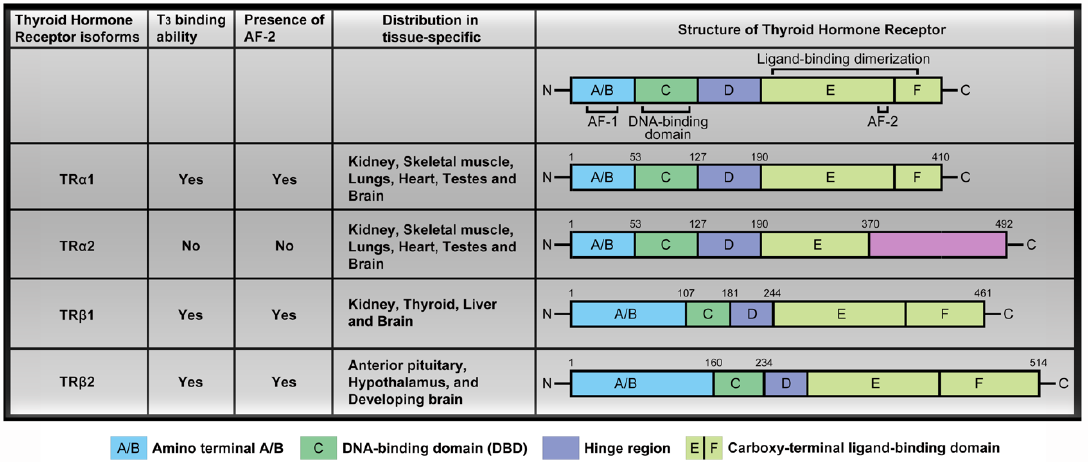
Figure 1. Thyroid hormone receptors (TR) isoforms and structure distribution. Thyroid hormone receptors (TR) contain several domains, specifically, amino-terminal A / B that may function as a gene enhancer, DNA-binding domain (DBD), hinge region containing the nuclear localization signal and carboxy-terminal ligand-binding domain that binds T 3 . The four major TR isoforms, TR α 1, TR α 2, TR β 1, and TR β 2 undergo TH binding and are widely distributed in a tissue-specific manner, such as TR α 1 and TR α 2 are expressed in the kidney, skeletal muscle, lungs, heart, and testes, with particularly high levels detected in the brain. TR β 1 expression is significant in the brain, thyroid, liver, and kidney while the TR β 2 isoform is specifically expressed in the anterior pituitary, hypothalamus, and developing brain.